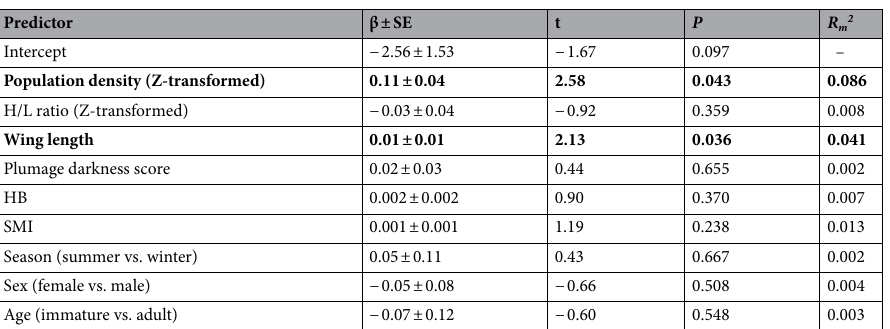
Table 1. The effects of population density, physiological stress (heterophil/lymphocyte ratio, H/L ratio), body size (wing length), plumage darkness score, blood haemoglobin concentration (HB), scaled mass index (SMI), season, sex and age on induced (PHA) immune response, as assessed with generalized linear mixed model fitted with Restricted Maximum Likelihood (REML). The plot identity was used as the random factor. The semi-partial R m2 represents the percentage of variance explained by each predictor. Significant predictors are marked in